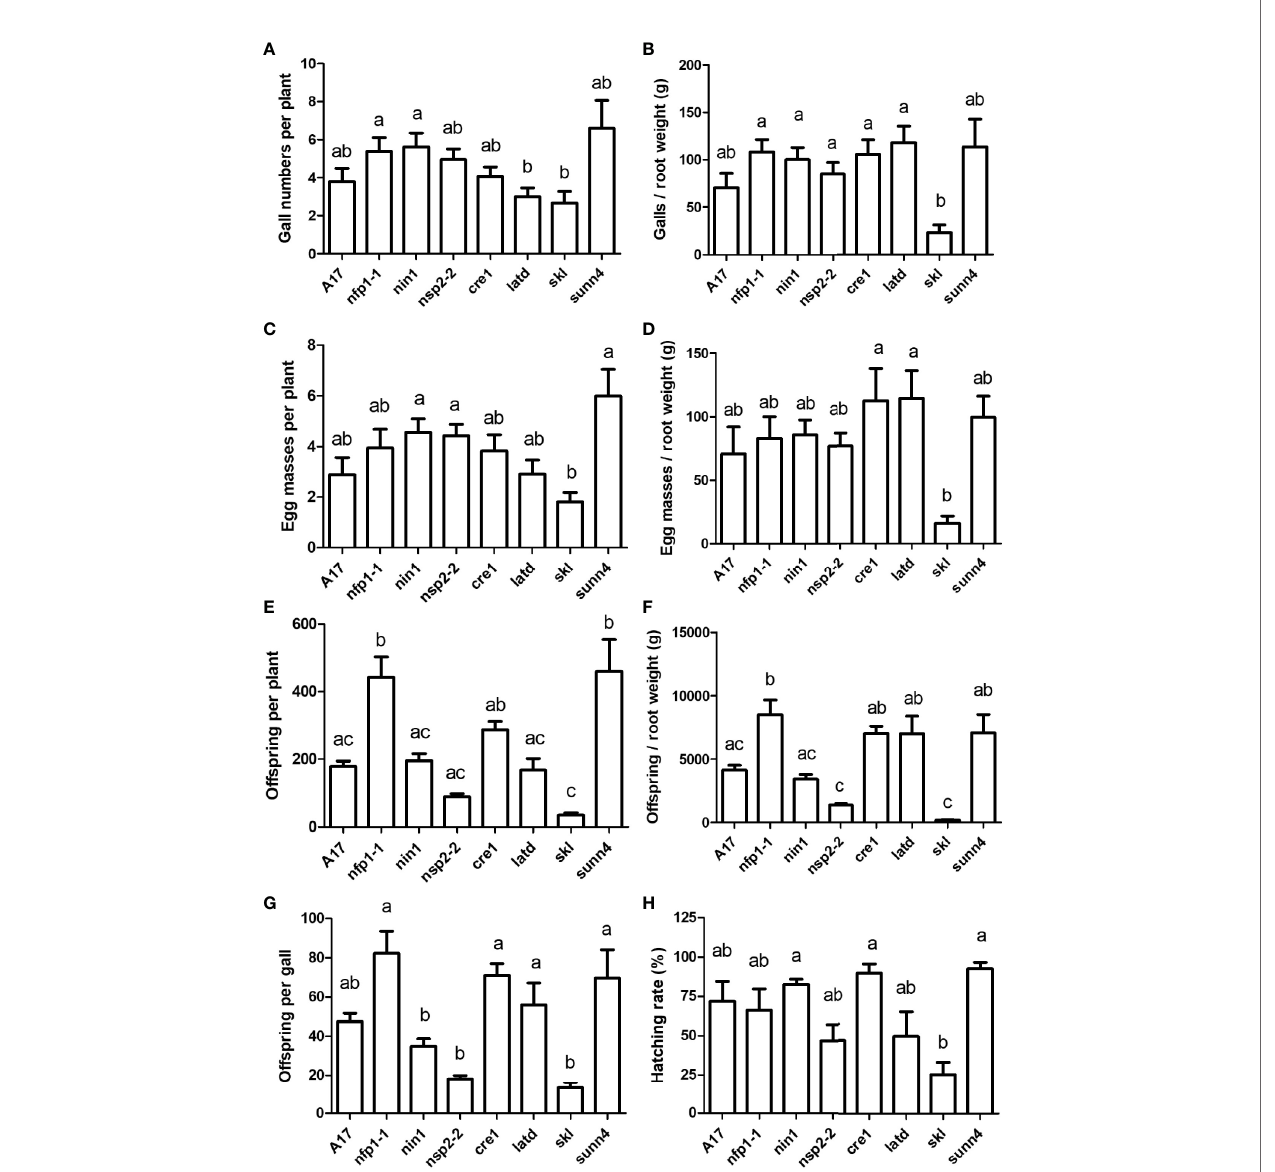
FIGURE 2 | Nematode infection phenotypes of Medicago truncatula wild type and nodulation mutants. J2s of Meloidogyne javanica grown initially on WT plants were hatched and inoculated onto roots of different M. truncatula genotypes. All phenotypes were recorded at 35 days post inoculation. (A) Numbers of galls per plant. (B) Number of galls normalized against root weight. (C) Number of egg masses per plant. (D) Number of egg masses normalized against root weight. (E) Total offspring per plant (sum of unhatched eggs and hatched J2s after one week of incubating the harvested egg masses). (F) Total offspring normalized against root weight. (G) Total offspring per gall. (H) Hatching rate calculated as the numbed of hatched J2s/total number of eggs and J2s after one week of incubating the harvested egg masses. N = 17 – 25 plants for each genotype, with n = 5 for sunn4 . Graphs show means and standard errors. Means with different letters differ signi fi cantly from each other with p < 0.05 (one-way ANOVA with Tukey ’ s